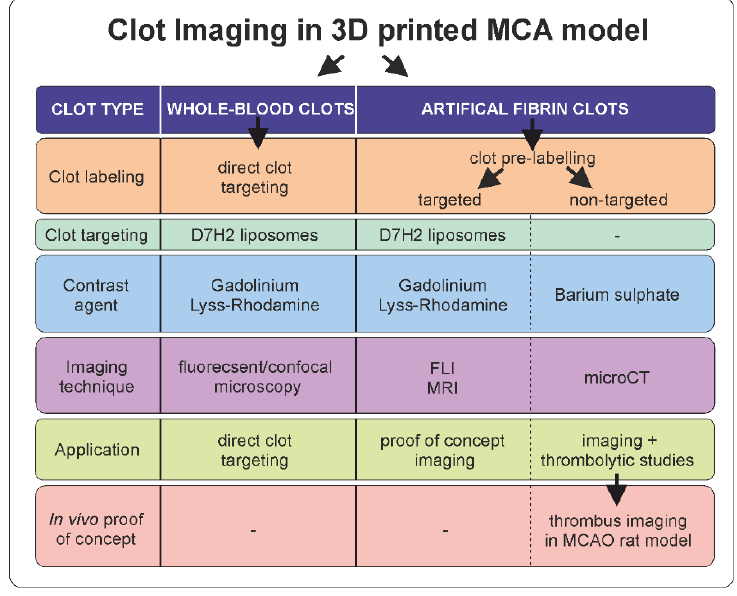
Figure 1. Workflow of clot imaging experimental set up using three-dimensional (3D) printed middle cerebral artery (MCA) model.